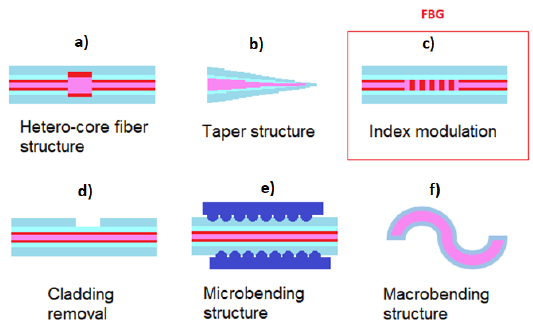
Figure 3. Sensors geometries: ( a ) hetero-core fibre structure, ( b ) taper structure, ( c ) FBG, ( d ) cladding removal, ( e ) micro-bending structure, and ( f ) macro-bending structure.